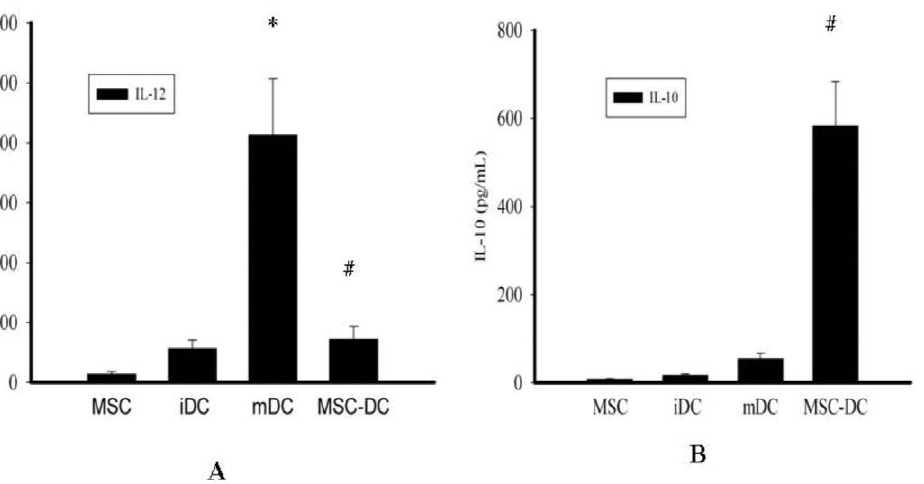
Figure 3. IL-10 and IL-12 secretion as assessed by ELISA. (A) IL-12 secreted in monocultures of MSCs, iDCs and mDCs and in the co-culture of MSC-DC (MSC:DC=1:10). (B) IL-10 secreted in monocultures of MSCs, iDCs and mDCs and in the co-culture of MSC-DC (MSC:DC=1:10). *P , 0.05(mDC